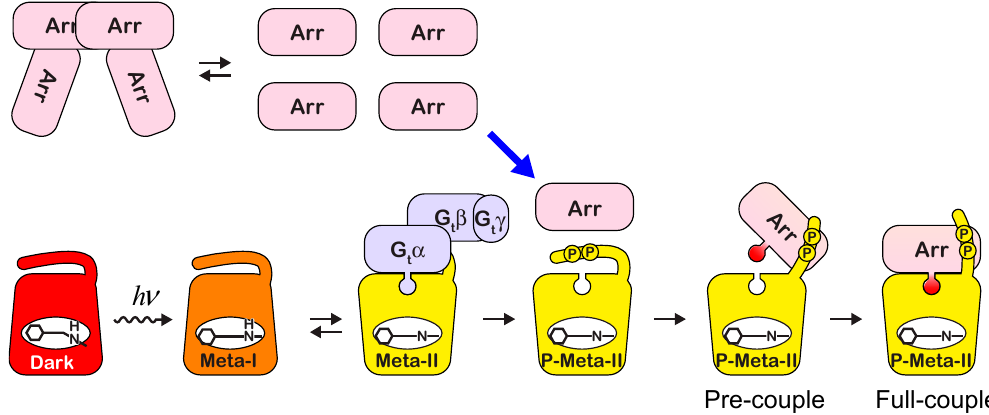
Figure 7. Monomer/tetramer equilibrium of arrestin and interaction with phosphorylated rhodopsin. Tetramer buffers monomer concentration to prevent fluctuations in quenching efficiency. Formation of the pre-coupling complex is essential to releasing the finger loop of arrestin.